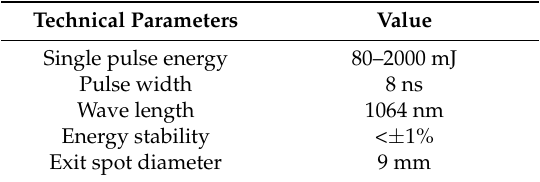
Table 2. The technical parameters of the Spitlight 2000 Nd:YAG